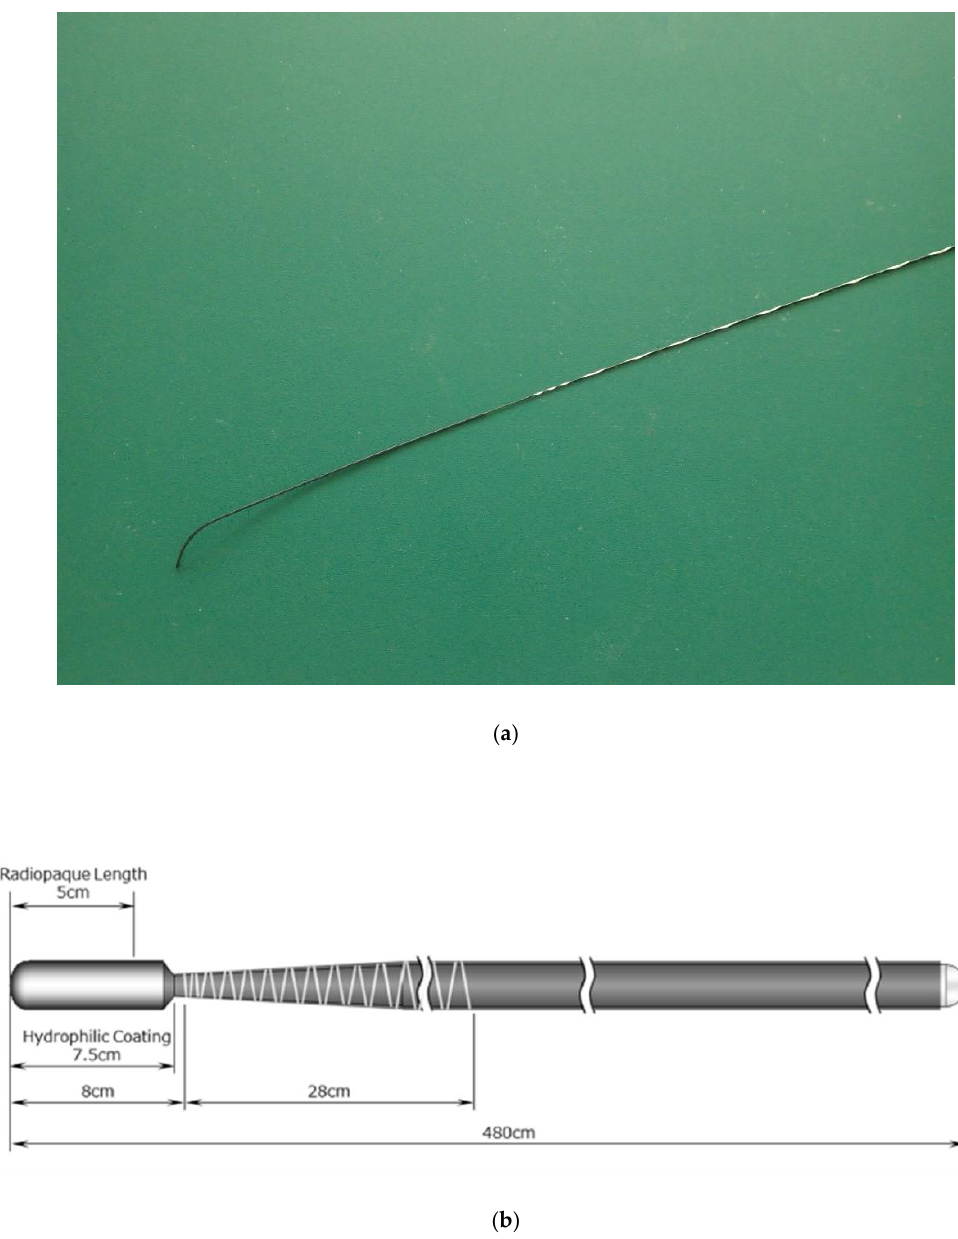
Figure 1. Properties of the M-Through guidewire (GW; Asahi Intecc Corp., Aichi, Japan). ( a , b ) The M-Through has a highly flexible 75 mm hydrophilic coated tip with a 50 mm (length) radiopaque jacket (schema provided by Hirata Company, Osaka, Japan).